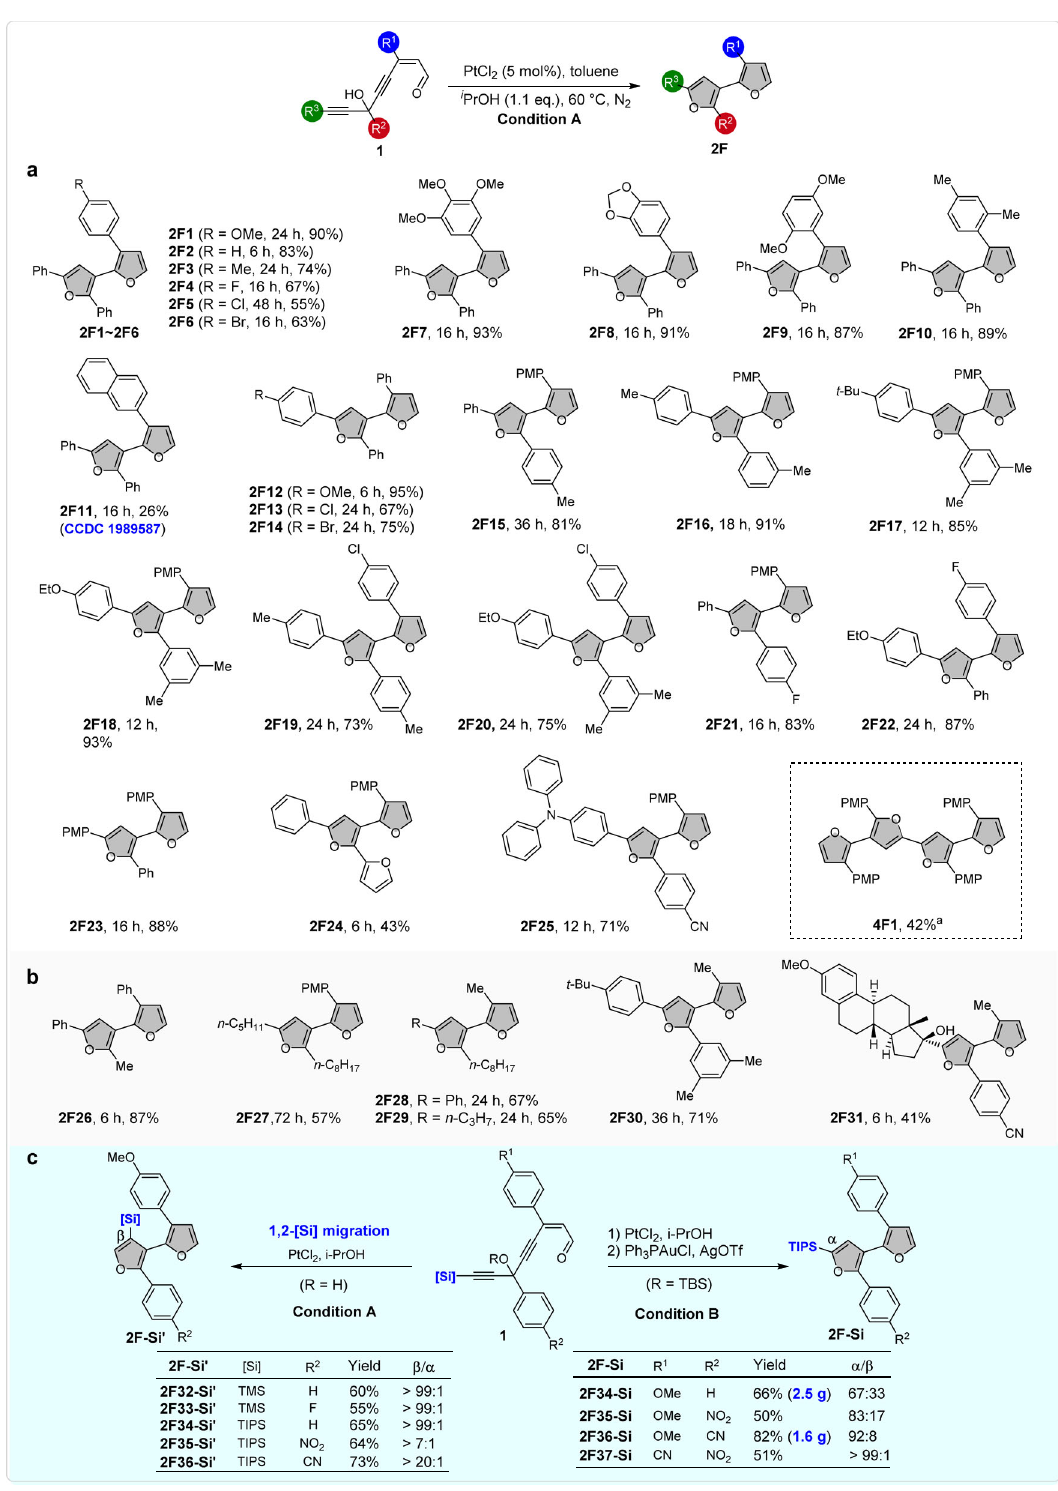
Fig. 2 Substrate scope of bifurans. a Scope of aryl-substituted bifurans. b Scope of alkyl-substituted bifurans. c Scope of silyl-substituted bifurans. Unless otherwise noted, the reactions were carried out in 0.2 mmol scale under the standard conditions, PMP = p -MeO-C 6 H 4 ; (i) PtCl 2 (5 mol%), i PrOH (1.1 eq.), toluene, 60 °C; (ii) (MeCN) 4 CuPF 6 (5 mol%), toluene, 120 °C. Condition A for 1,2-[Si] migration: PtCl 2 (5 mol%), i PrOH (1.1 eq.), toluene, 60 °C. Condition B for the synthesis of α -silyl-bifuran: (i) PtCl 2 (5 mol%), i PrOH (1.1 eq.), toluene, 60 °C; (ii) PPh 3 AuCl (5 mol%)/AgOTf (5 mol%), toluene, 90 °C. α / β -Regioselectivities were measured based on 1 H NMR of the crude products.